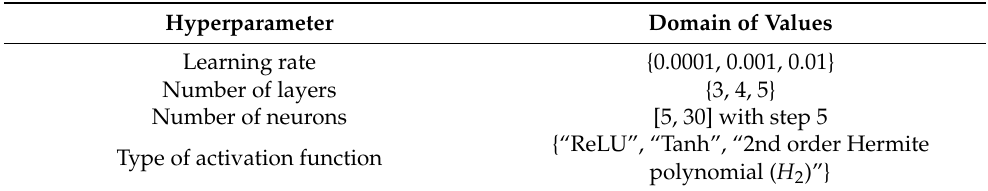
Table 3. The hyperparameter search space.